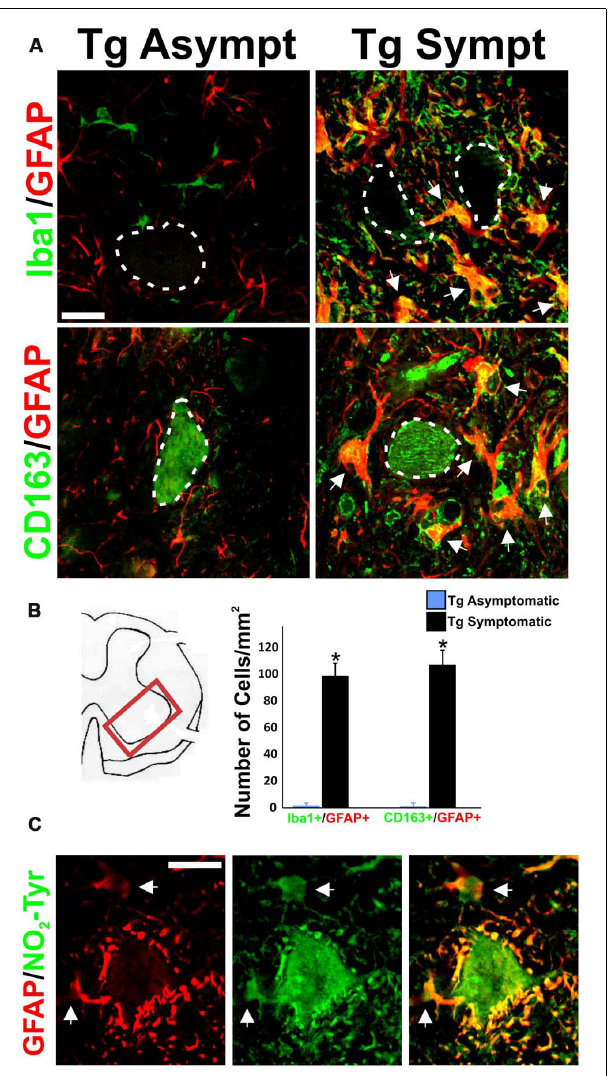
FIGURE 2 | Concurrent expression of microglia and astrocytic markers inAbA cells.(A) Representative image of GFAP (red), Iba1 (green), and CD163 (green) in lumbar spinal cord sections from transgenic asymptomatic (Tg-asymp) and symptomatic (Tg-sympt) SOD1 G93A rats. Dotted lines indicate motor neuron cells bodies, which artifactually stained for CD163. Note that microglia and astrocytes in asymptomatic rat expressed GFAP and Iba1 in well-segregated cell populations. In comparison, most of the Iba1 + and CD163 + cells also expressed GFAP in symptomatic animals (arrows). (B) Quantification of cells expressing Iba1/GFAP and CD163/GFAP in the lumbar spinal cord.The counting was performed in 10 histological sections per animal.Two different rats were used for each condition. Data are shown as mean ± SD; * P < 0.05. (C) Representative confocal immunostaining against GFAP (red) and nitrotyrosine (NO 2 − Tyr, green) in the ventral horn of a symptomatic rat showing the intense nitration of Perineuronal AbA cells (arrows). Scale bars: 20 μ m.